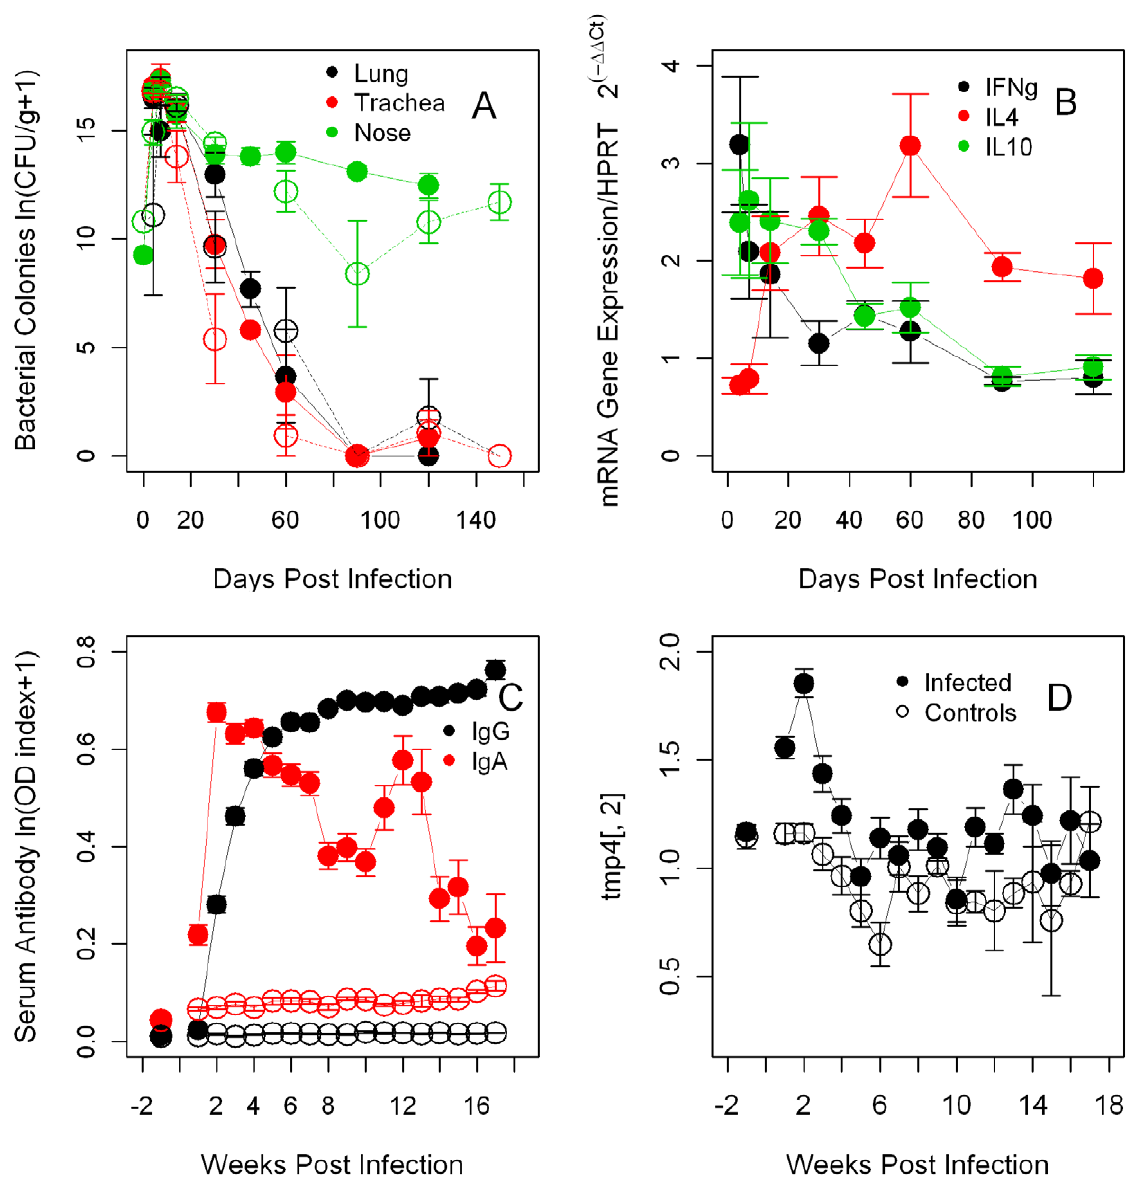
Figure 9. Summary of B.bronchiseptica intensity and immune variables from the experimental co-infection. Mean 6 SE during the course of the infection (days or weeks post infection) are reported. A - Bacterial intensity in the respiratory tract. For comparison, empty black circles represent the bacterial intensity in the lungs from the single infection. B - Cytokines, IFN c , IL4 and IL10 in the lungs. C - Anti-bacterial IgA and IgG in serum. D - Peripheral neutrophils. For C and D, infected hosts: full circles, controls: empty